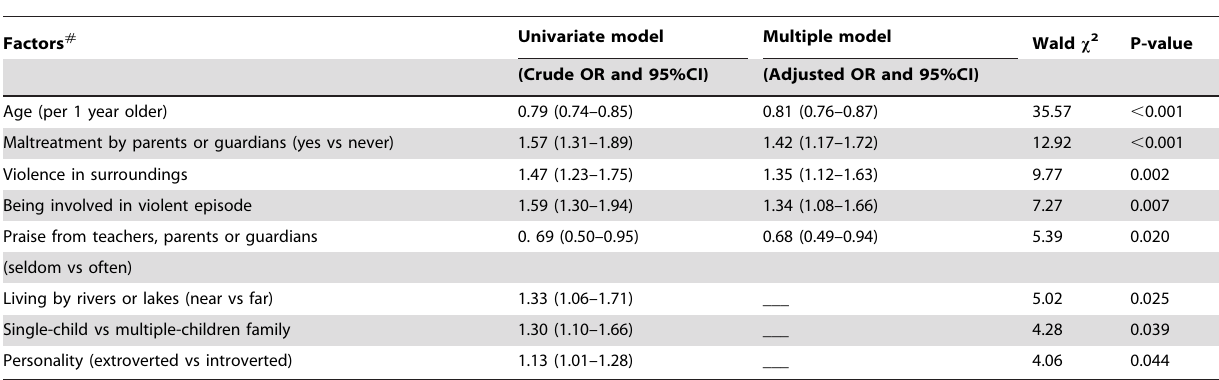
Table 3. Risk factors of injury among school-aged rural